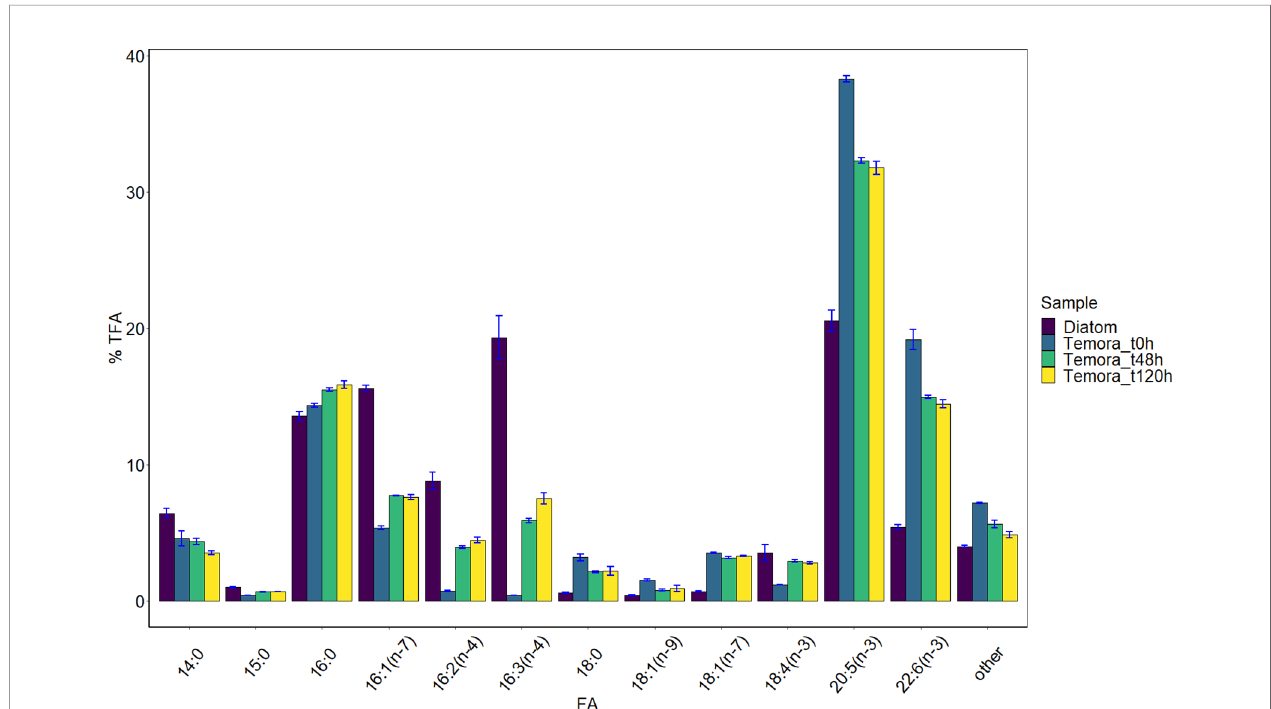
FIGURE 2 | Fatty acid pro fi le of diatom cultures and copepods (at the three sampling times). Mean relative values (% TFA) and standard deviation bars (atop each FA bar) are shown for major FAs (>1% TFA) and for the sum of minor FAs (referred to as “ other ” ).